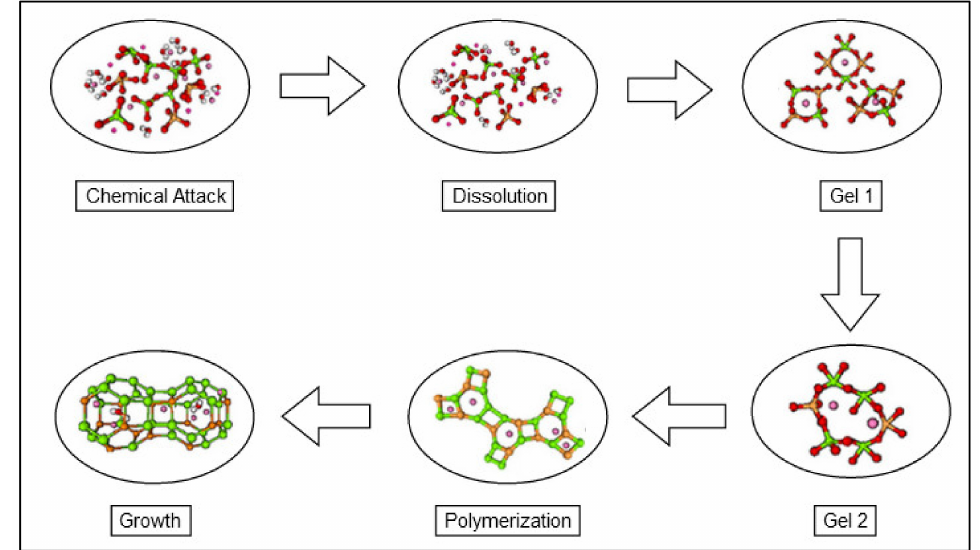
Figure 1. Conceptual design of the geopolymerization